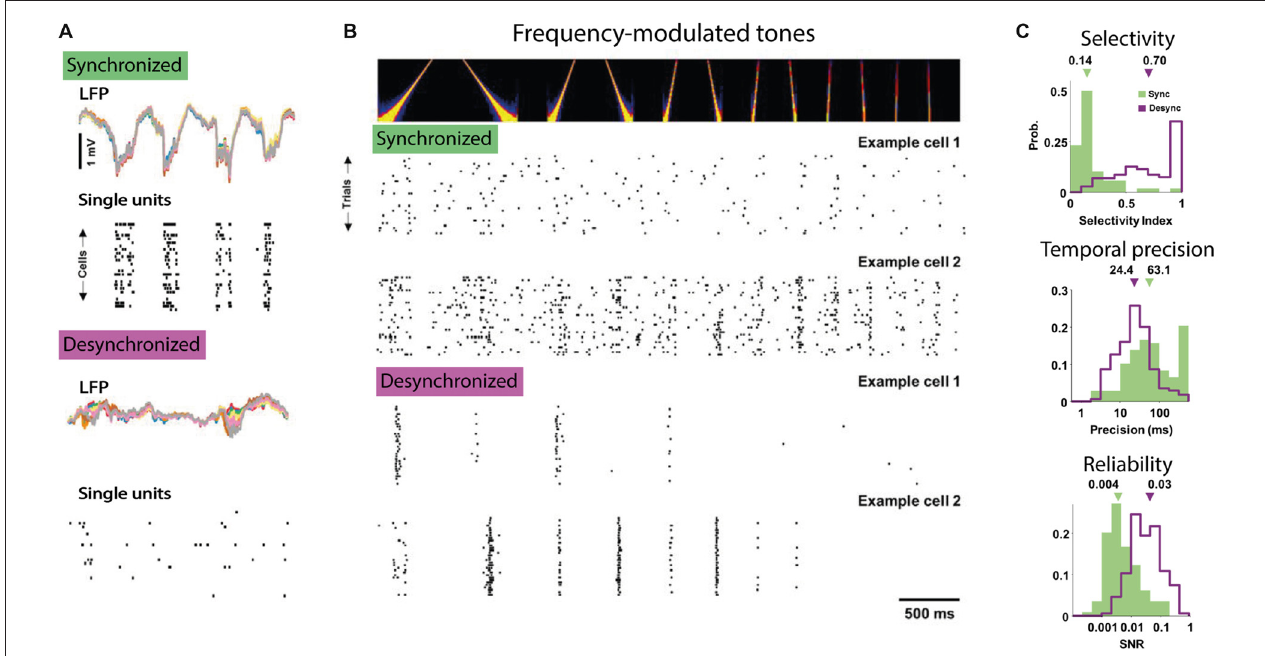
FIGURE 2 | The desynchronized state facilitates feature coding by single neurons. (A) Example of simultaneous LFP and single neuron activity in anesthetized auditory cortex of gerbils in the synchronized (top) and desynchronized state (bottom). Note that in the synchronized state most single unit activity tracks the large-amplitude fluctuations in the LFP. (B) Responses to tones are more selective and reliable over stimulus repetitions in the desynchronized state. Top panel shows the auditory spectrogram of the frequency modulated tone and the bottom panel shows the responses in rasterplots for two example cells to repetitions of the same stimulus recorded in the synchronized (top) and desynchronized state (bottom). Note the temporally precise and selective activity of the two example cells in the desynchronized condition compared to the non-selective responses in the synchronized condition. (C) Three measures of improved feature coding by single neurons in the desynchronized state. Top responses to tones had higher direction selectivity index, e.g., preference for upward vs. downward frequency modulated sweeps (computed as: response to preferred direction − opposite)/(preferred + opposite). Middle: responses during the desynchronized state were more temporally precise in their spiking (computed as the amount of jitter necessary to render the response uninformative, low value is higher precision) and, bottom, had higher reliability (computed as the signal-to-noise ratio). All figures adapted under Creative Commons Attribution License from Pachitariu et al. (2015).